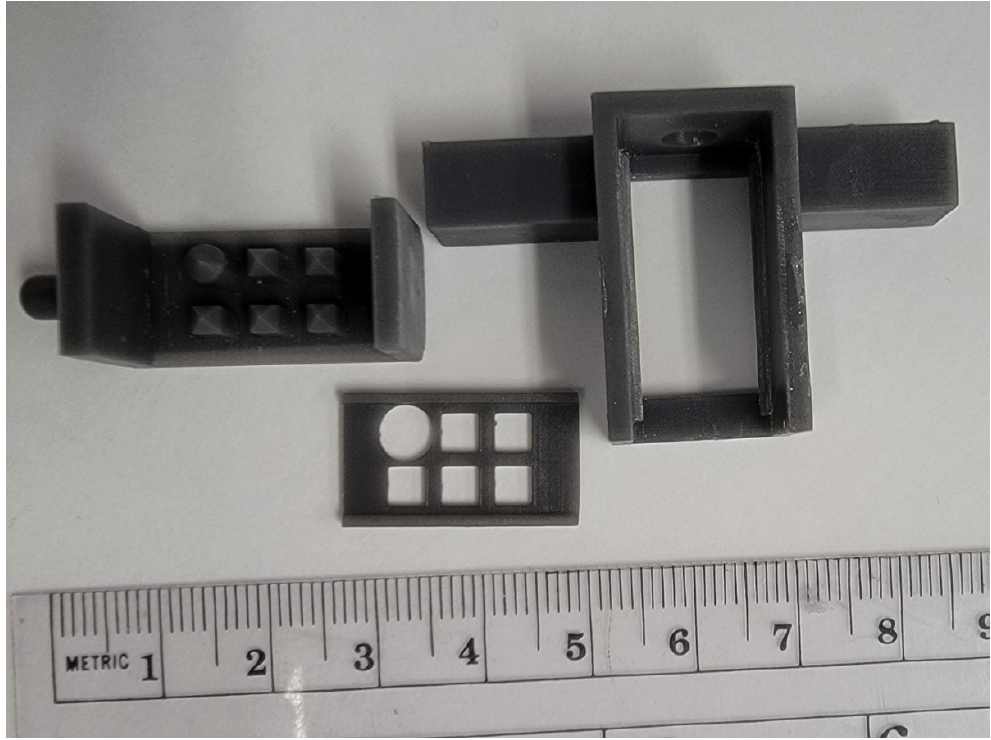
Figure 1. Plastic mold for gelatin mold. Lifter plate ( center ) is inserted into pillar mold ( left ), which is slotted into outer mold ( right ).